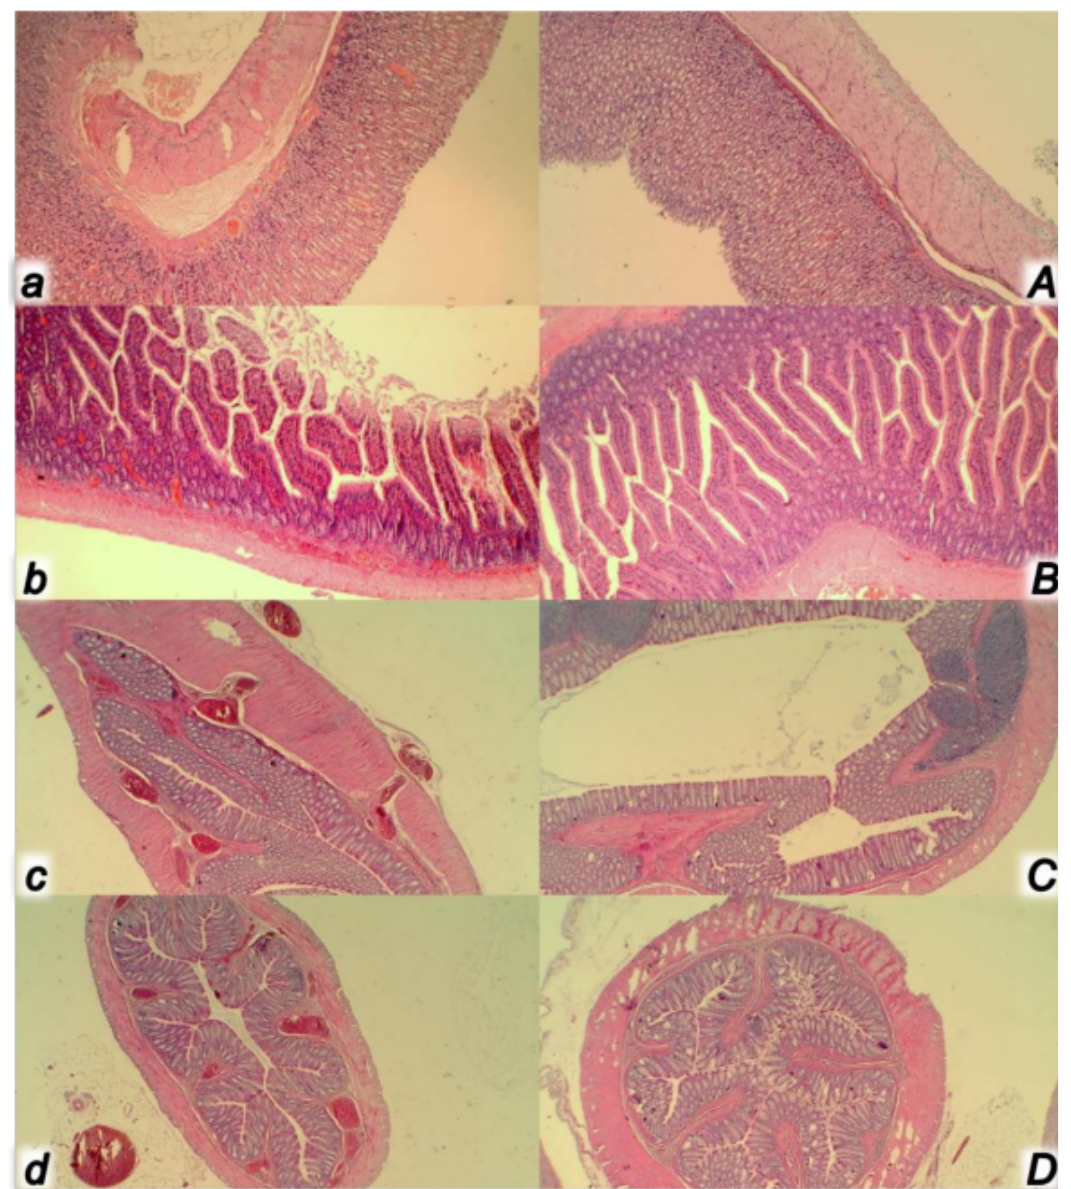
Figure 11. At 30 min ligation-time, microscopy presentation of the congestion of the stomach ( a , A ) and small intestine mucosa ( b , B ) and rectum ( c , C ) and perirectal vascular plexus ( d , D ) (HE, × 100) in the rats with occluded superior mesenteric vein and artery, controls (small letters) and BPC 157 treated (capitals). Control rats with occluded superior mesenteric vein and artery exhibited the congestion and dilatation of the small vessels in the stomach ( a ) and small intestine mucosa ( b ), congestion and dilatation of the small vessels of the rectum wall ( c ) along with congestion of perirectal blood vessels ( d ). Contrarily, BPC 157 treated rats showed no changes in the stomach ( A ) and small intestine mucosa ( B ) and no changes in the rectum ( C ) and perirectal vascular plexus ( D